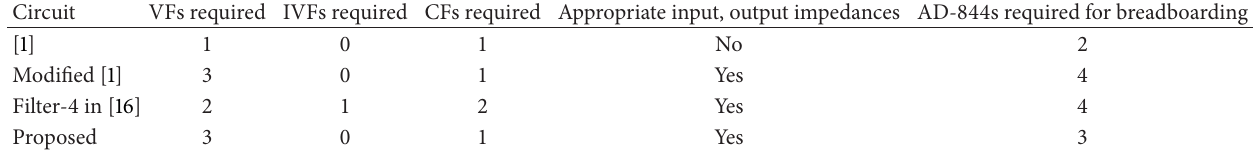
Table 1: Comparative